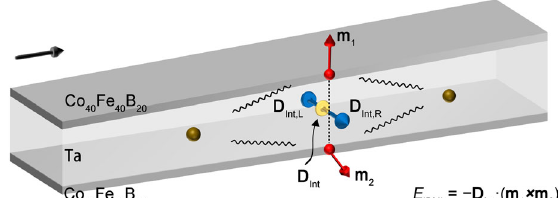
the top and bottom ferromagnetic layers,